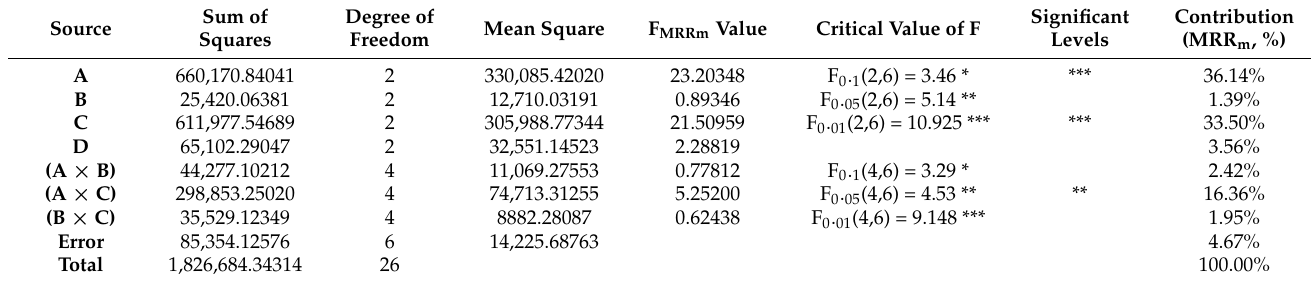
Table 5. ANOVA analysis for MRR m .